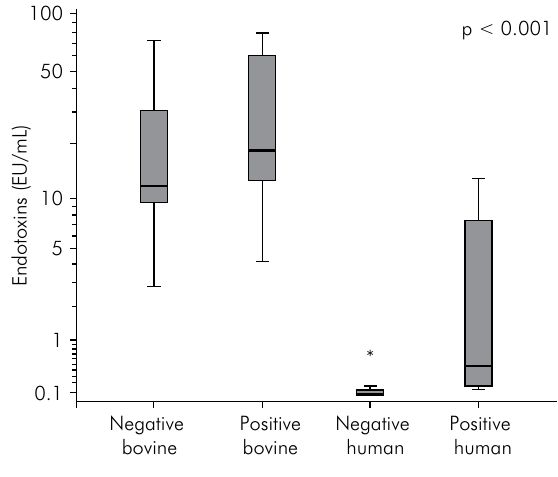
Figure. Each experimental group boxplot distribution of the endotoxin concentration in